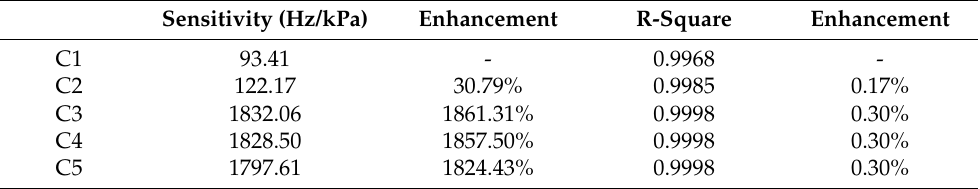
Table 7. Pressure sensitivity, linear fit, and enhancement of C1–C5.